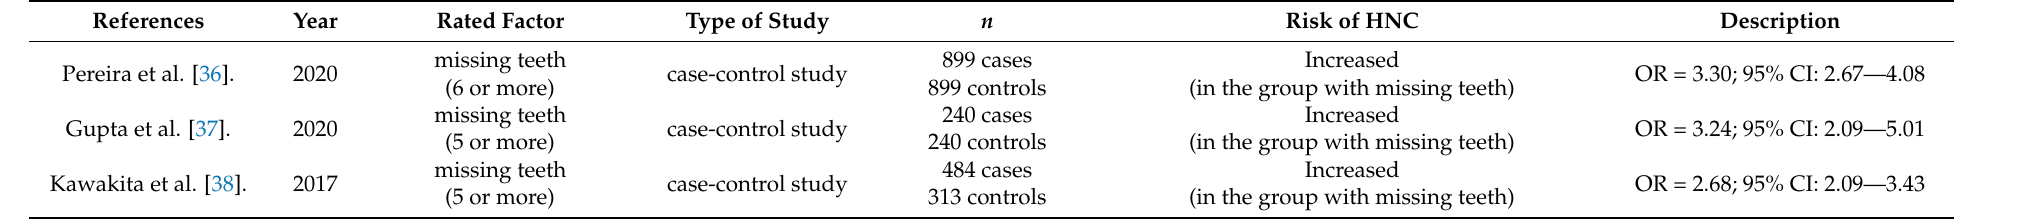
Table 2. The impact of occurrence of missing teeth on risk of developing head and neck squamous cell